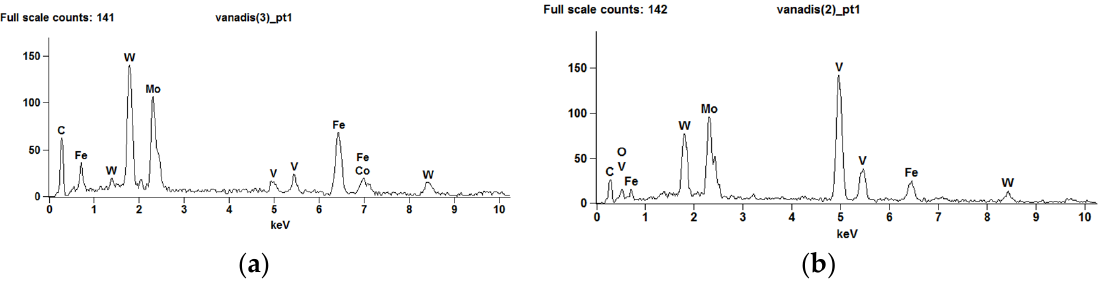
Figure 4. X ‐ ray dispersive energy spectrum of the areas M 6 C ( a ) and MC ( b ) visible in Figure 3.